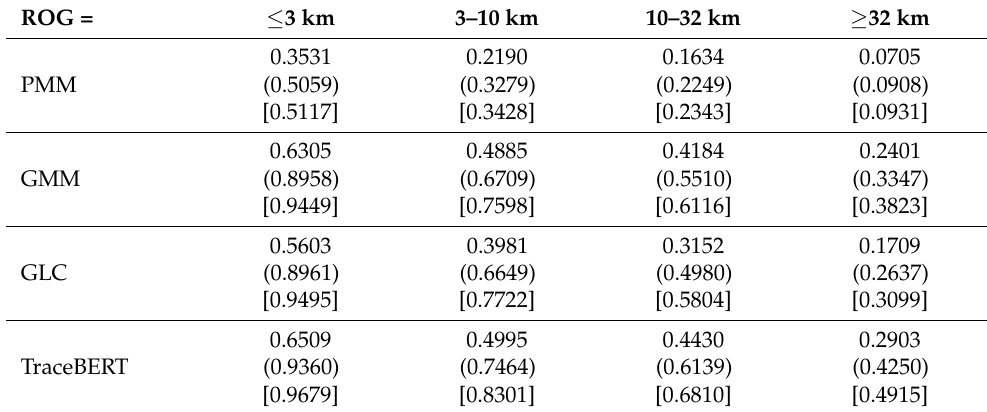
Table 3. Comparison of top-1 accuracy, top-3 accuracy (in round brackets), and top-5 accuracy (in square brackets) for different ranges of the radius of gyration.